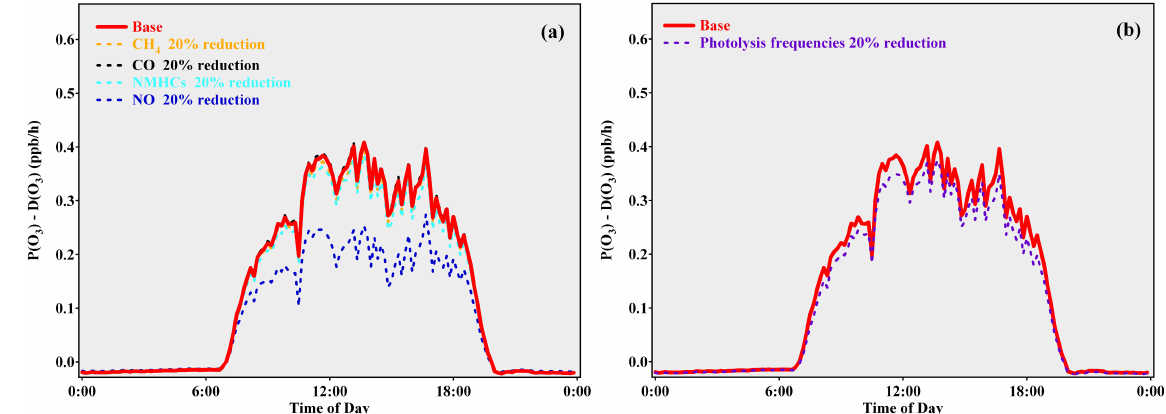
Fig. 6. Sensitivity of summertime O 3 production rates to (a) ozone precursors and (b) photolysis frequencies at